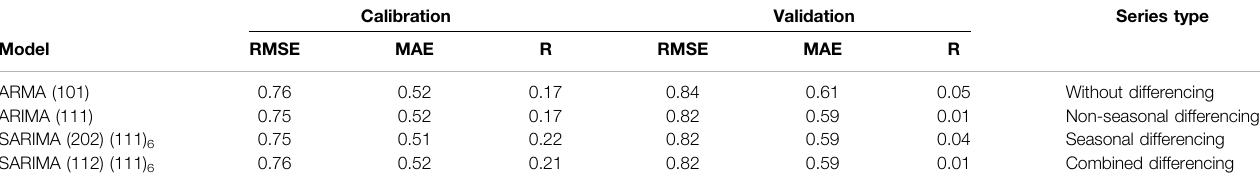
TABLE 8 | Results of evaluating the best models in differencing states for the one-month drought index.